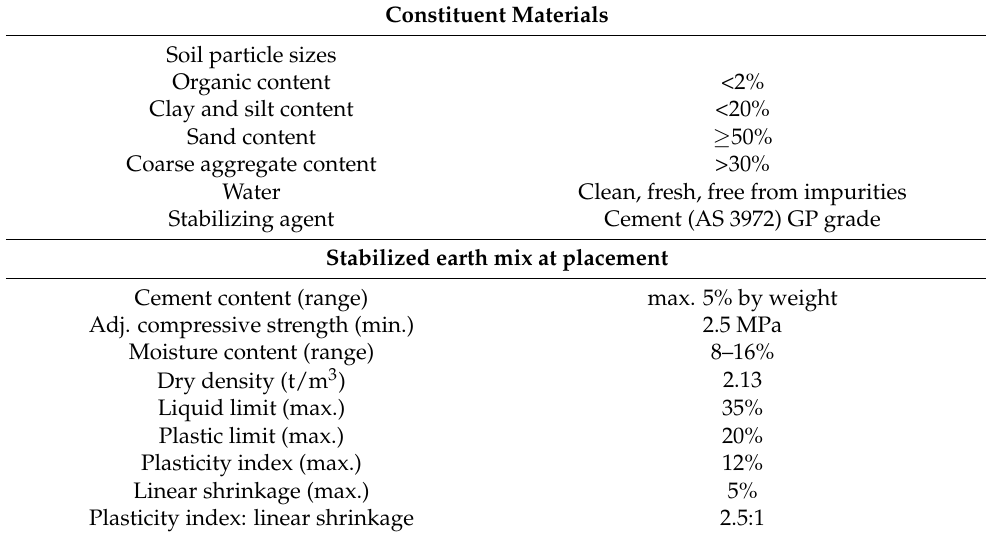
Table 2. Specifications for the buildings.